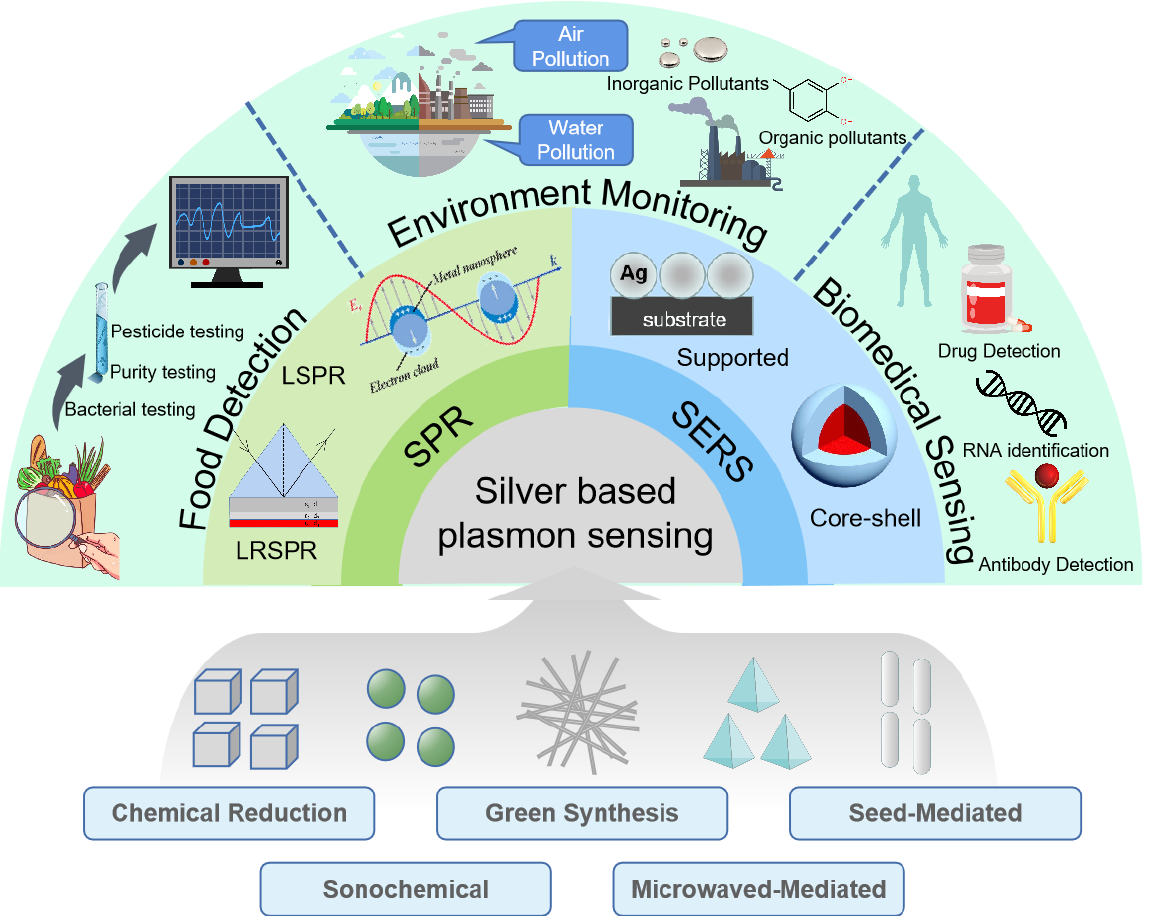
Figure 8. Applications of silver-based plasmon sensing in three fields: food detection, environment monitoring, biomedical sensing.